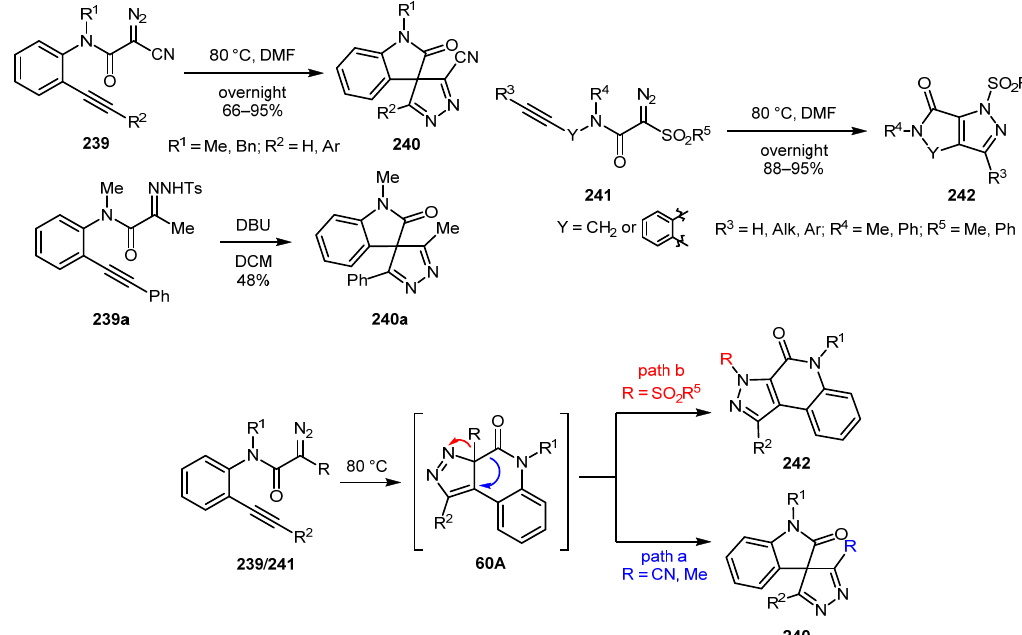
Scheme 60. Synthesis of spiro-4 H -pyrazoles 240 and fused 1 H -pyrazoles 242 from alkyne-tethered diazo A continuous-flow synthesis of fluoroalkyl-substituted diazomethanes 244 from the corresponding amines 243 and their application in [3+2]-cycloaddition reactions with var- ious alkynes and alkenes was described by Mertens and co-workers (Scheme 61) [124]. The method proved to be efficient for the preparation of fluoroalkyl-substituted 1 H -pyra- zoles 248 , pyrazolines 249 , and 3 H -pyrazoles 250 with absolute regioselectivity in gener- ally good to excellent yields. An approach for the preparation of mono-, bis-, and tris(tri- fluoromethyl)-substituted pyrazoles from ethyl 2-diazo-3,3,3-trifluoropropanoate has also been reported by the Reissig group [125]. Scheme 61. Continuous-flow synthesis of fluoroalkyl-substituted diazomethanes for preparation of 1 H -pyrazoles, pyrazolines, and 3 H -pyrazoles.